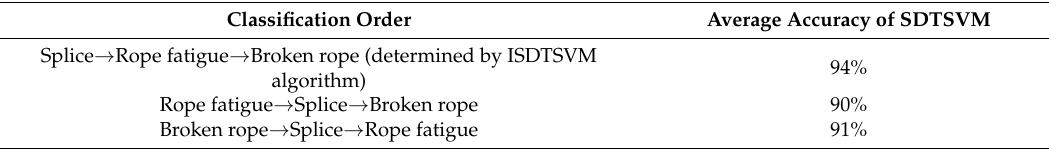
Table 5. Classification results of the steel cord conveyor belt defects signals for three classification orders using the SDTSVM algorithm with a radial basis function kernel and a five-fold